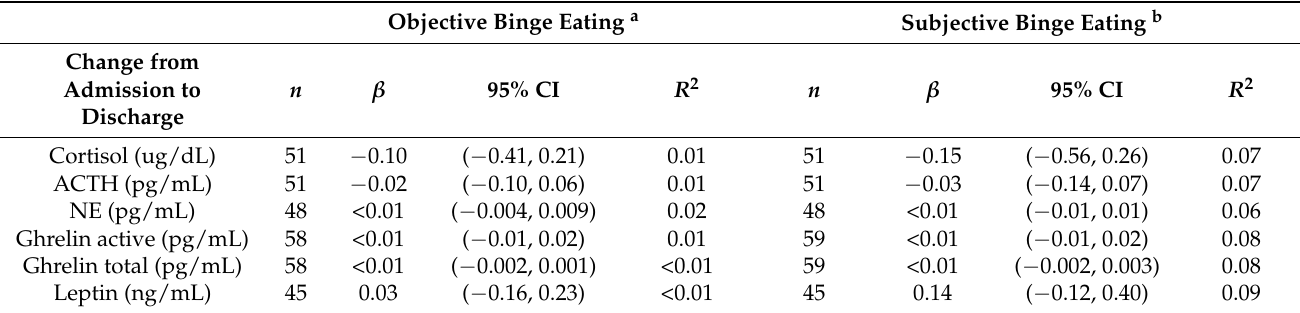
Table 3. Multiple linear regression results for associations of changes in hormone levels with objective and subjective binge-eating episodes at 3 months